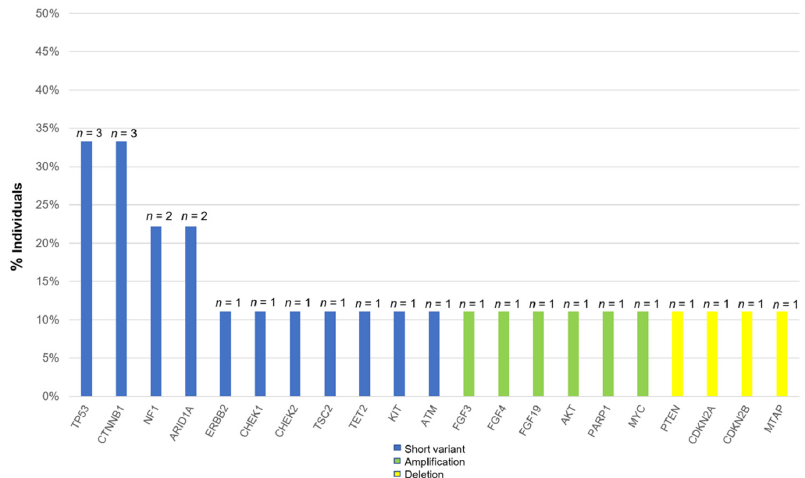
Figure 1. Percentage of all alterations in patients with unresectable hepatocellular carcinoma.